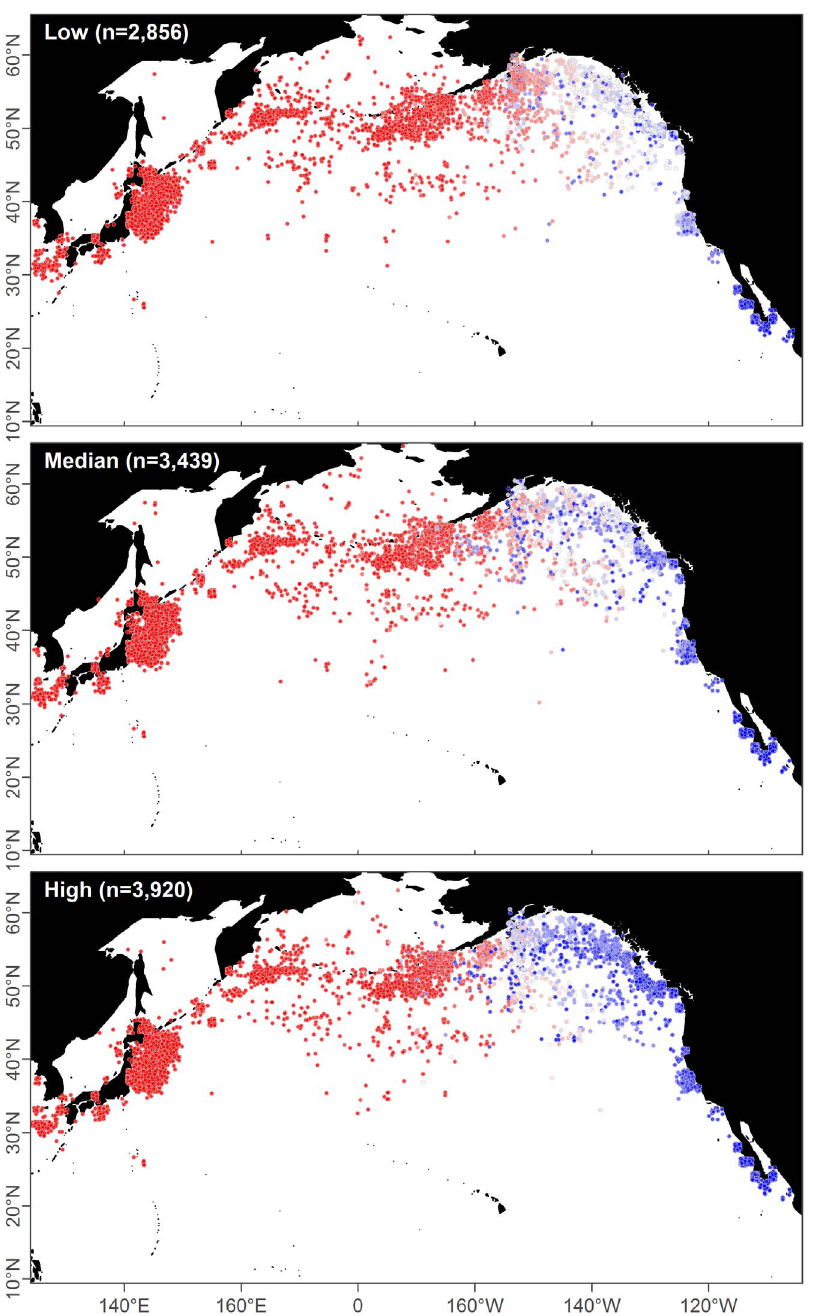
Figure 12. Example model predictions. Catches of ENP (blue) and WNP (red) blue whales for three realizations chosen to represent low, median, and high total ENP catches. Catch positions are plotted with a small amount of noise to prevent overplotting, and are different between the three cases because they are drawn randomly from potential locations. Nearby catches can have different predictions (colors) because months are